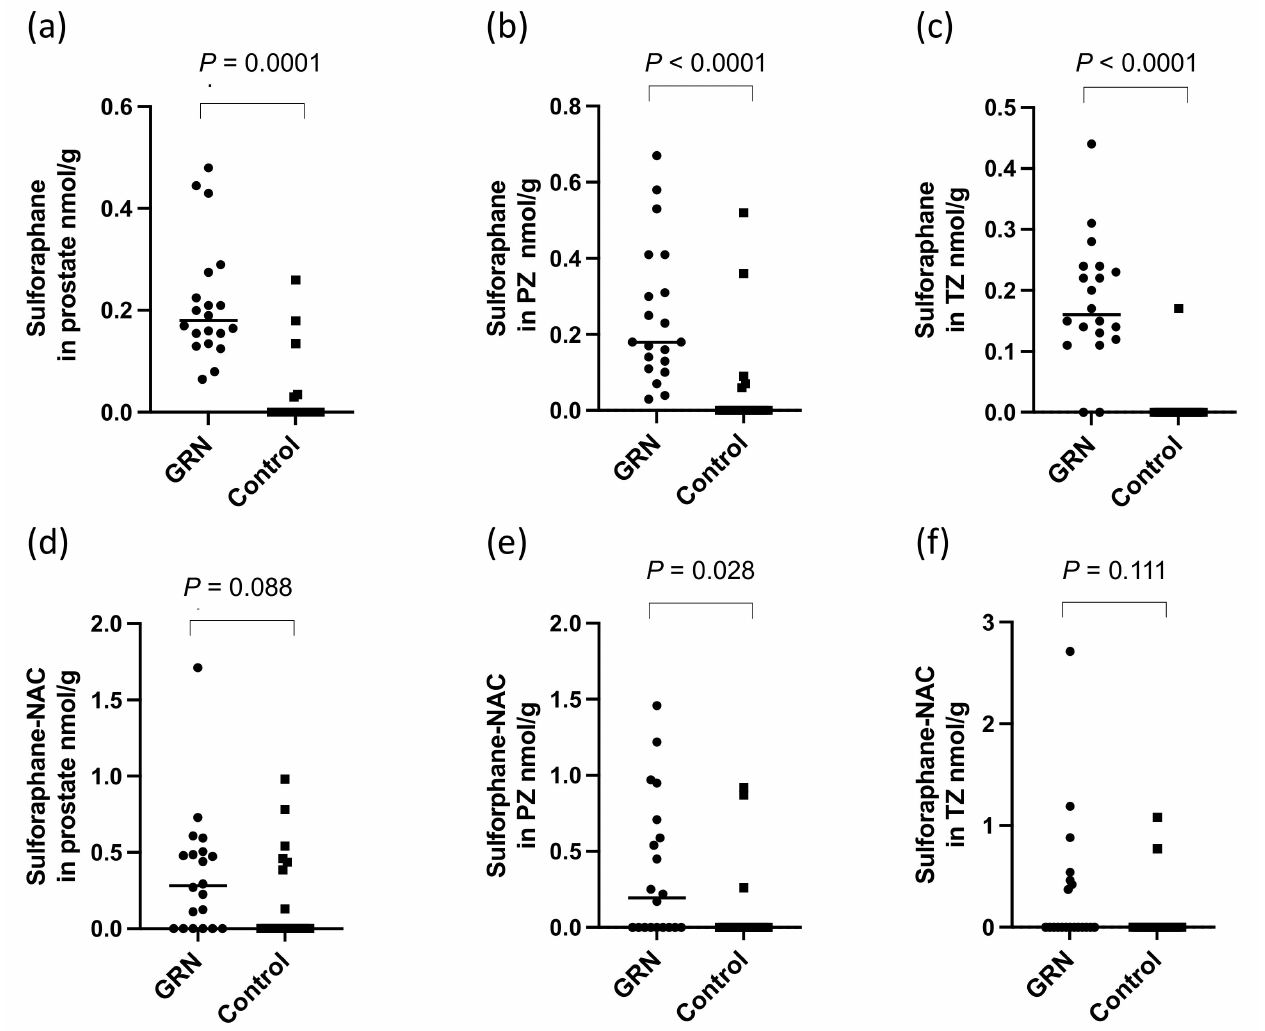
Figure 4. Sulforaphane in ( a ) prostate, ( b ) PZ and ( c ) TZ and sulforaphane-NAC in ( d ) prostate, and ( e ) PZ and ( f ) TZ in prostate following consumption of the GRN supplement or not (control). All p -values are from Mann–Whitney